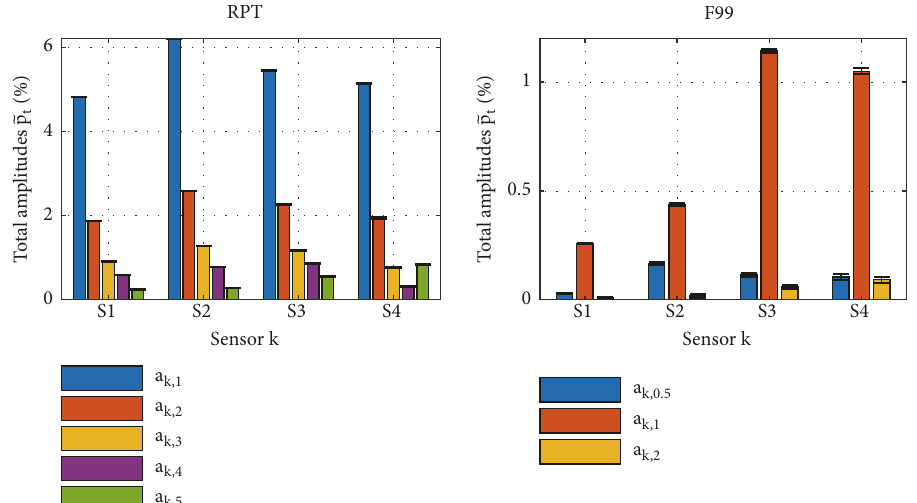
Figure 8: The blade passing frequency amplitude with 95% probability for each sensor. The amplitude is percentage of specific energy. The subscript k is the sensor number S1 to